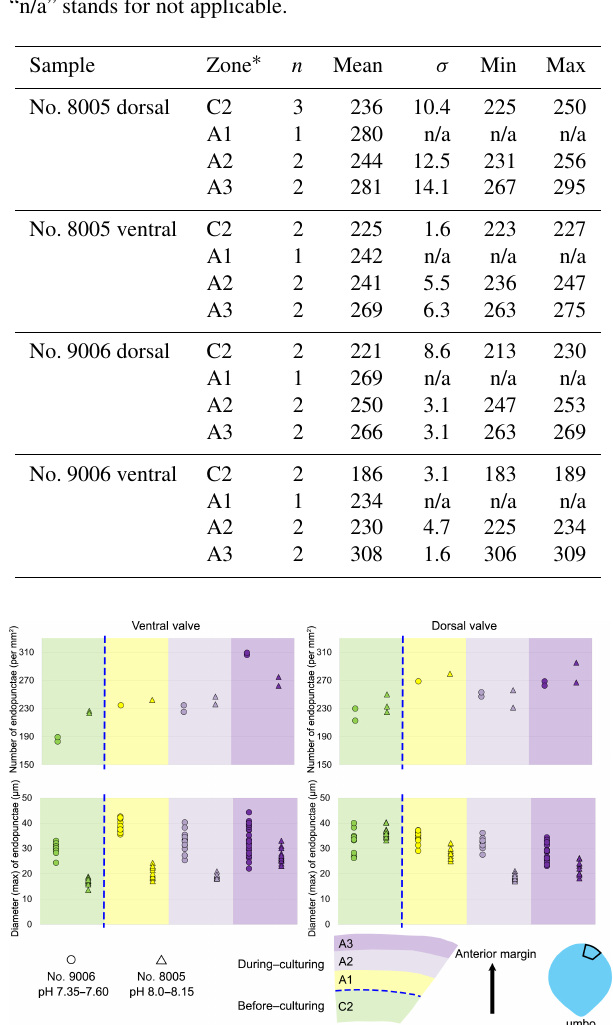
Table 6. Statistical comparison of the number of endopunctae (per mm 2 ) on both valves of no. 8005 and no. 9006. ∗ Position of zones before-culturing : C2, and during-culturing : A1, A2, A3 (cf. Fig. 7). “n/a” stands for not applicable.